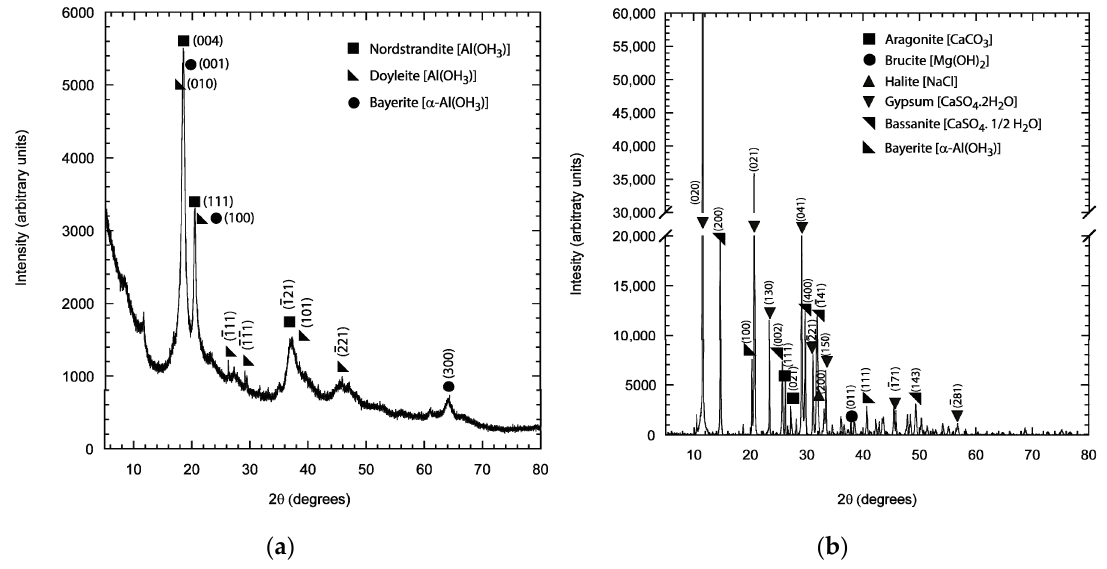
Figure 7. X ‐ ray diffraction (XRD) pattern of ( a ) the deposit collected from the surface of the TSA, and ( b ) from the holiday/damage region. The pattern shown here was collected from the specimen with one holiday/damage (18.3% area).